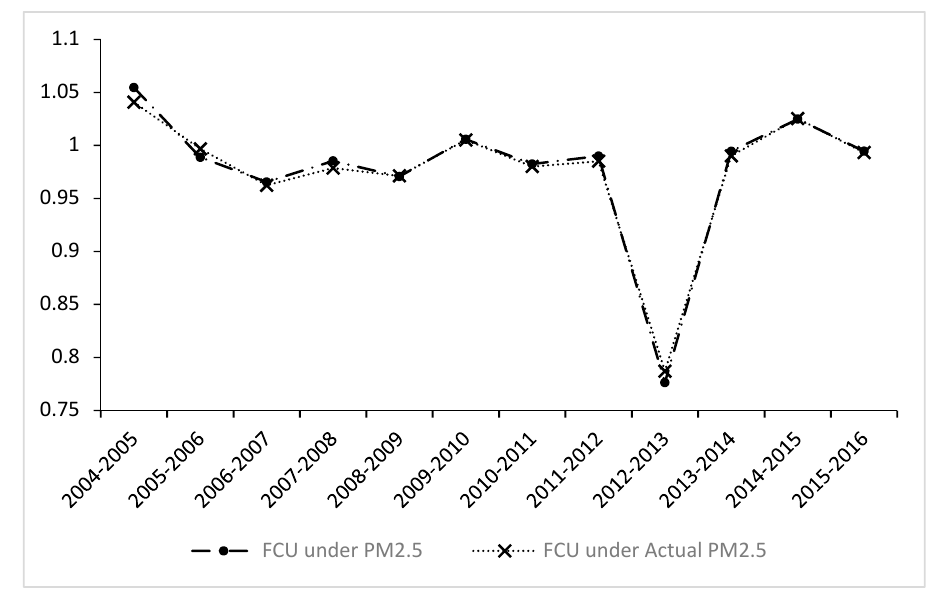
Figure 5. The dynamic trend of the frontier catch-up (FCU) index under PM 2.5 and actual PM 2.5 .